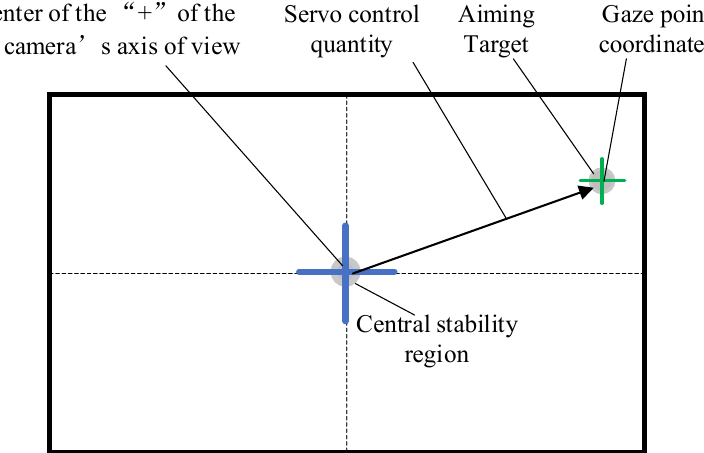
Figure 7. Relationship between gaze point and visual aiming of servo platform.